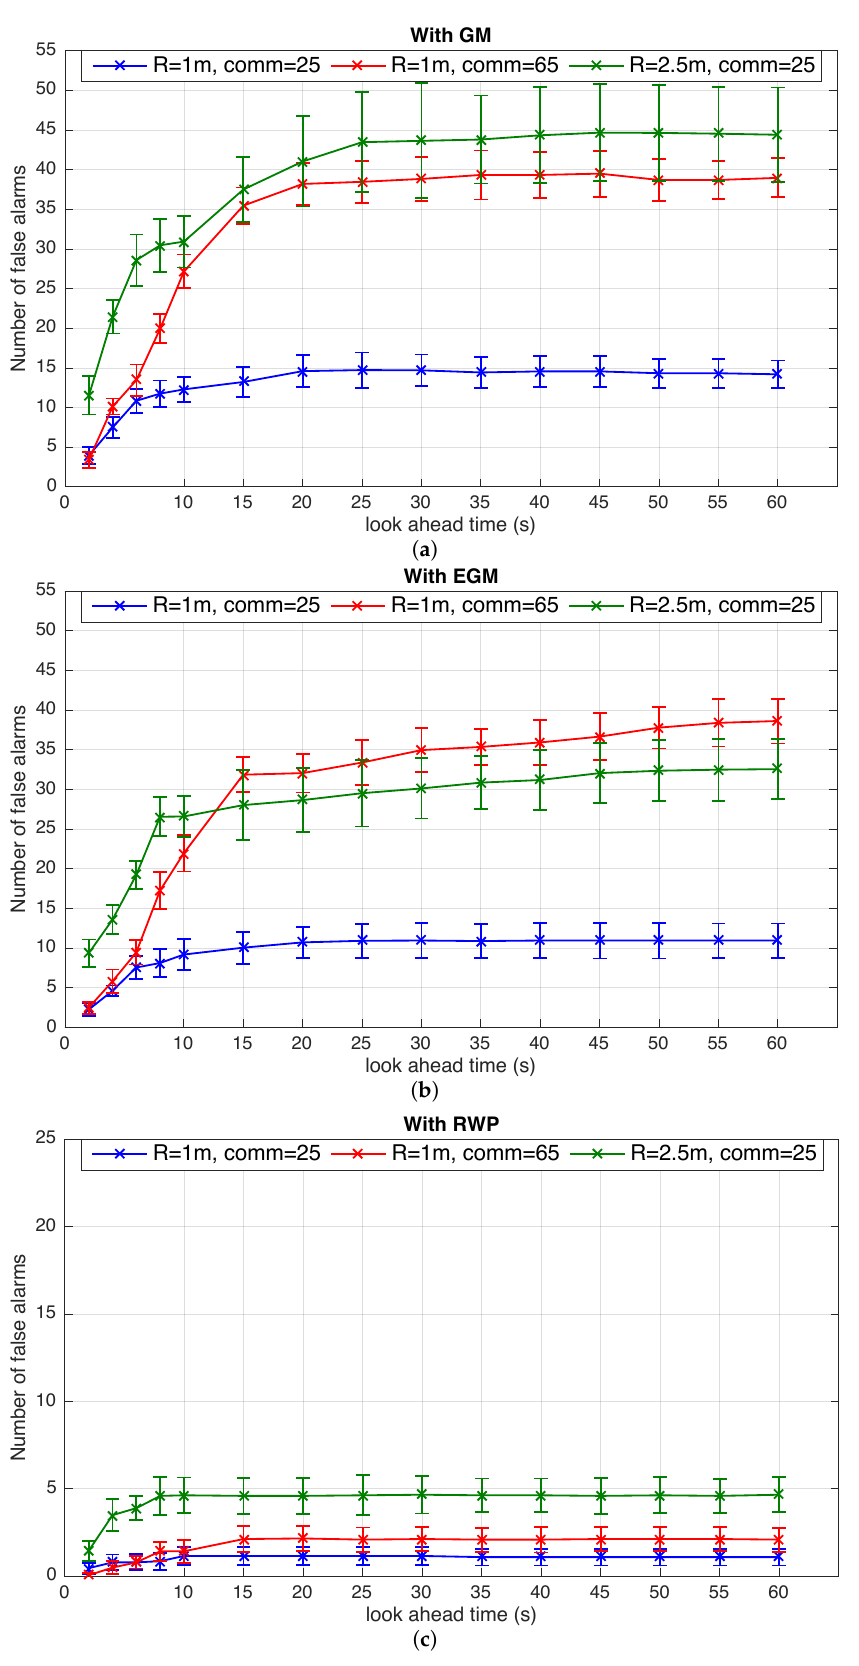
Figure 10. Number of false alarms under different T l , σ , and R using ( a ) GM; ( b ) EGM; ( c )